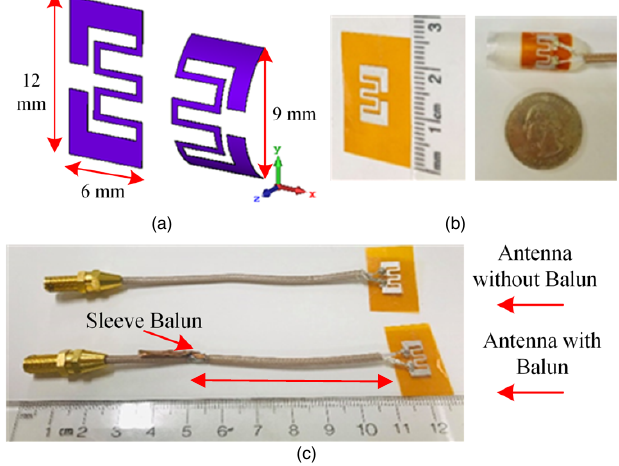
FIGURE 1. Configuration of (a) the proposed flat and bent loop antenna, (b) fabricated flat and bent antennas, and (c) antennas with and without Balun.